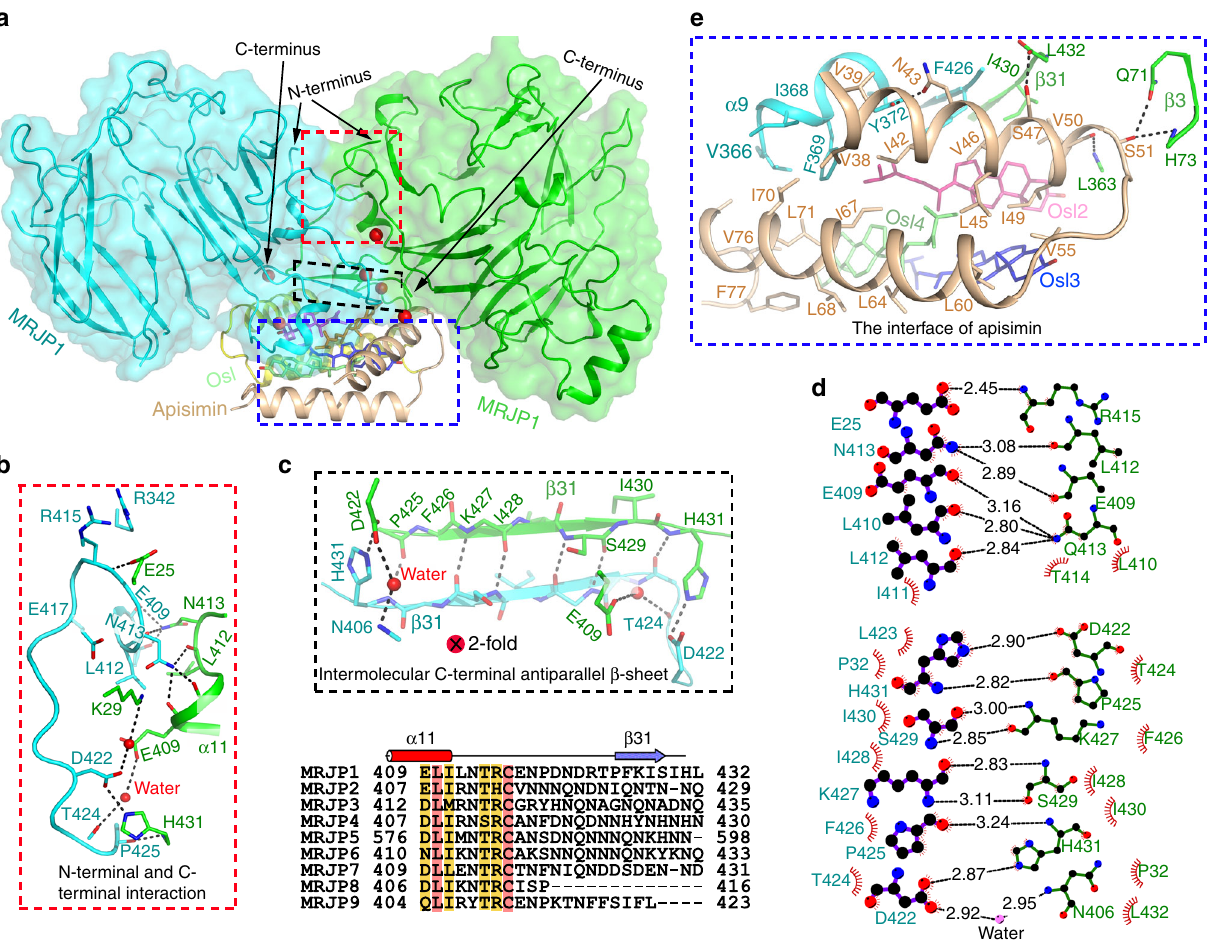
Fig. 4 Detailed interactions of MRJP1 and apisimin in the MRJP1 dimer. a Overview of the three protein interfaces. Details of the symmetric intermolecular C-terminal and N-terminal interactions ( b ) and intermolecular C-terminal antiparallel β -sheets β 31 ( c ), and their interactions ( d ) between MRJP1 protomers were calculated by Ligplot 70 . Hemispheres represent hydrophobic interactions, and lines represent polar interactions. Residues from the two protomers are shown on the left and right, respectively. All residues involved in the hydrophobic interactions are shown in black. For hydrophilic interactions, residues are shown in red or blue. e Details of the interactions of